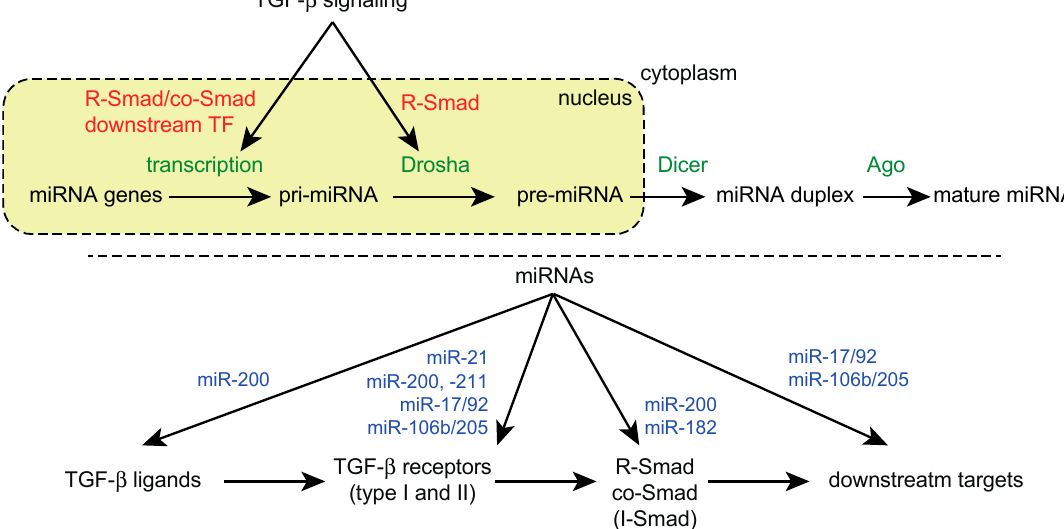
Figure 1. Reciprocal crosstalk between TGF- β signaling and miRNA machinery. ( Top ) Regulation of miRNA biogenesis by TGF- β signaling; ( Bottom ) Regulation of TGF- β signaling components by miRNAs. Examples of miRNAs targeting TGF- β signaling components are shown.